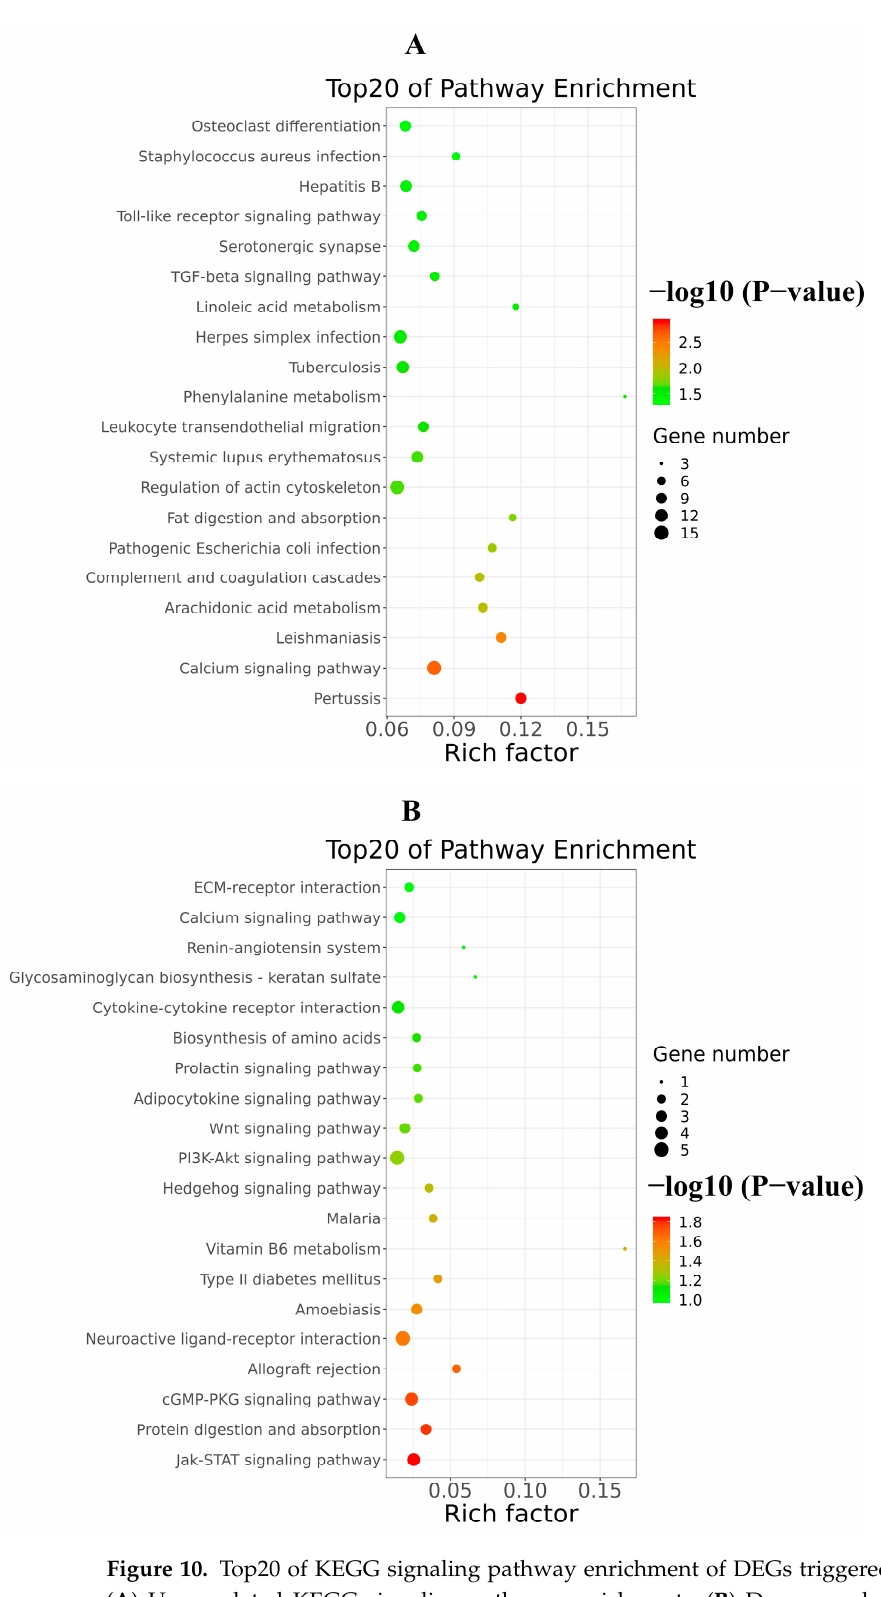
Figure 10. Top20 of KEGG signaling pathway enrichment of DEGs triggered by excessive RIG-I. ( A ) Up-regulated KEGG signaling pathway enrichment. ( B ) Down-regulated KEGG signaling pathway